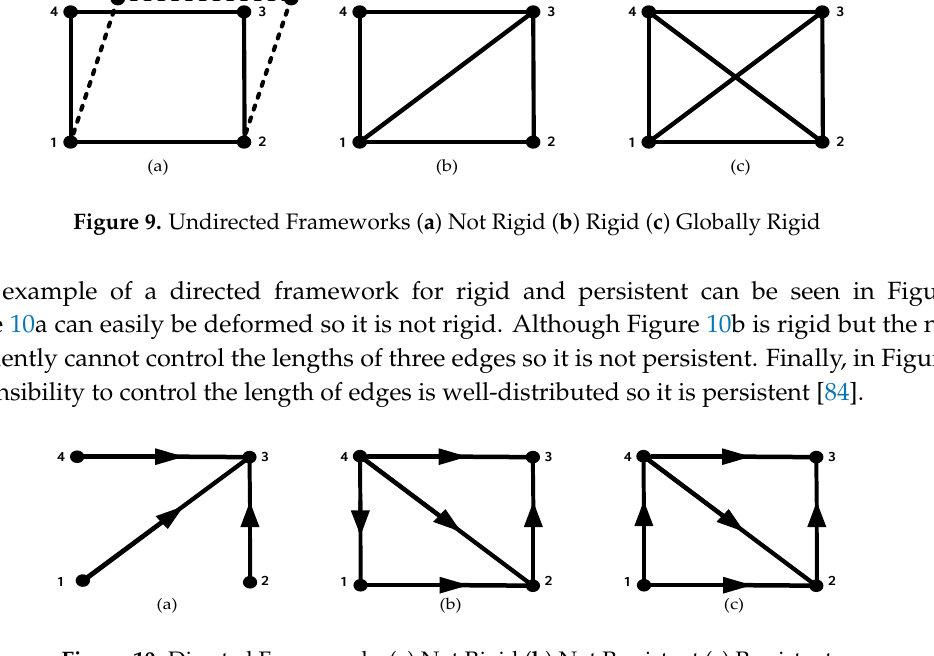
Table 3. Distinctions among position, displacement and distance ‐ based formation control [85].